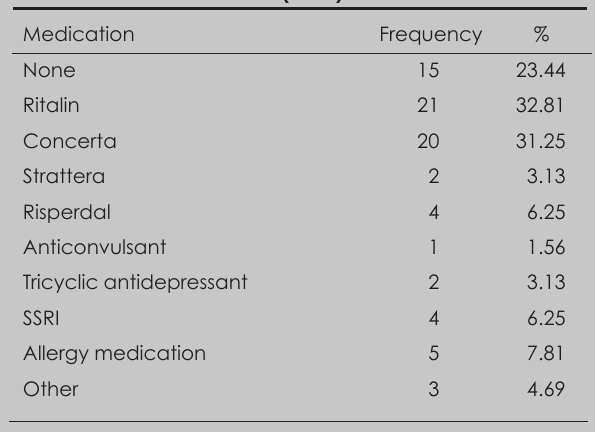
Table III. Current medications ( N =64)